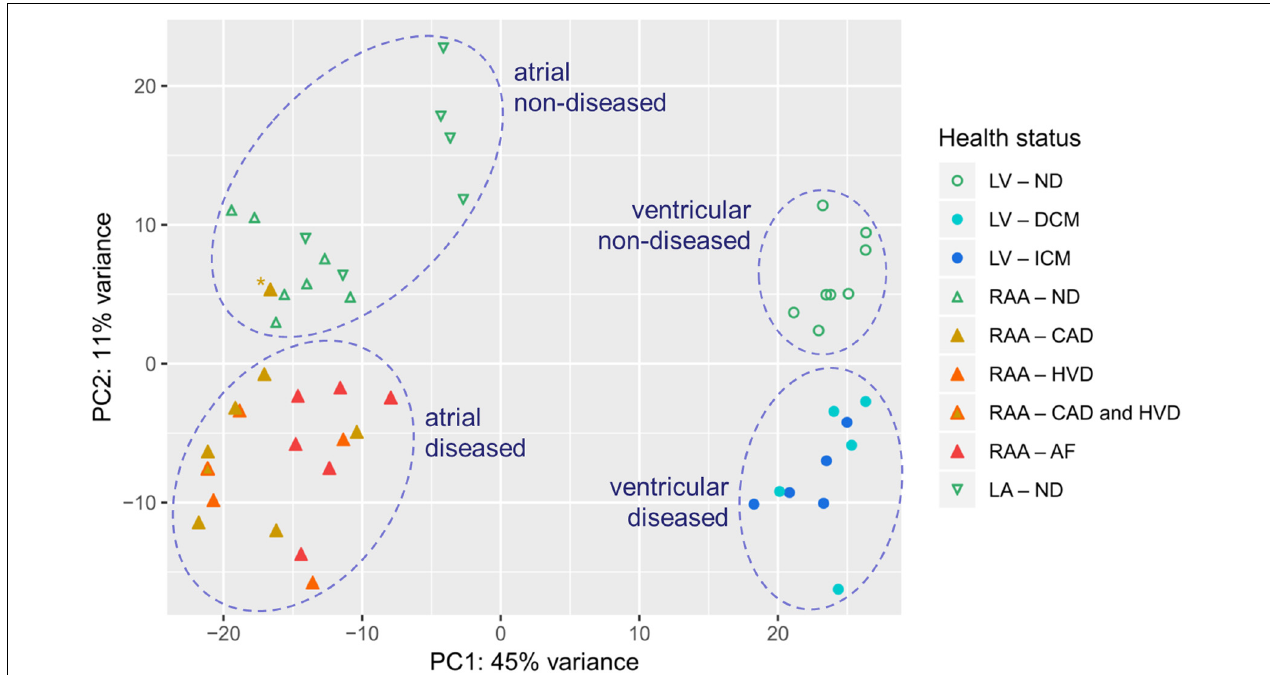
FIGURE 2 | PCA plot illustrating inter- and intra-group variability of samples assessed by RNA-seq. Each individual point represents data from one tissue sample. Dashed circles highlight clusters. ∗ indicates a data point showing discrepancy between clinical and experimental data. Sample provenance: left ventricle (LV; • ), right atrial appendage (RAA; (cid:78) ), left atrium (LA; (cid:72) ). Patient’s health status: non-diseased (ND; green, open symbols), dilated cardiomyopathy (DCM; light blue), ischemic cardiomyopathy (ICM; blue), coronary artery disease (CAD; ocher), heart valve disease (HVD; orange), atrial fibrillation (AF;